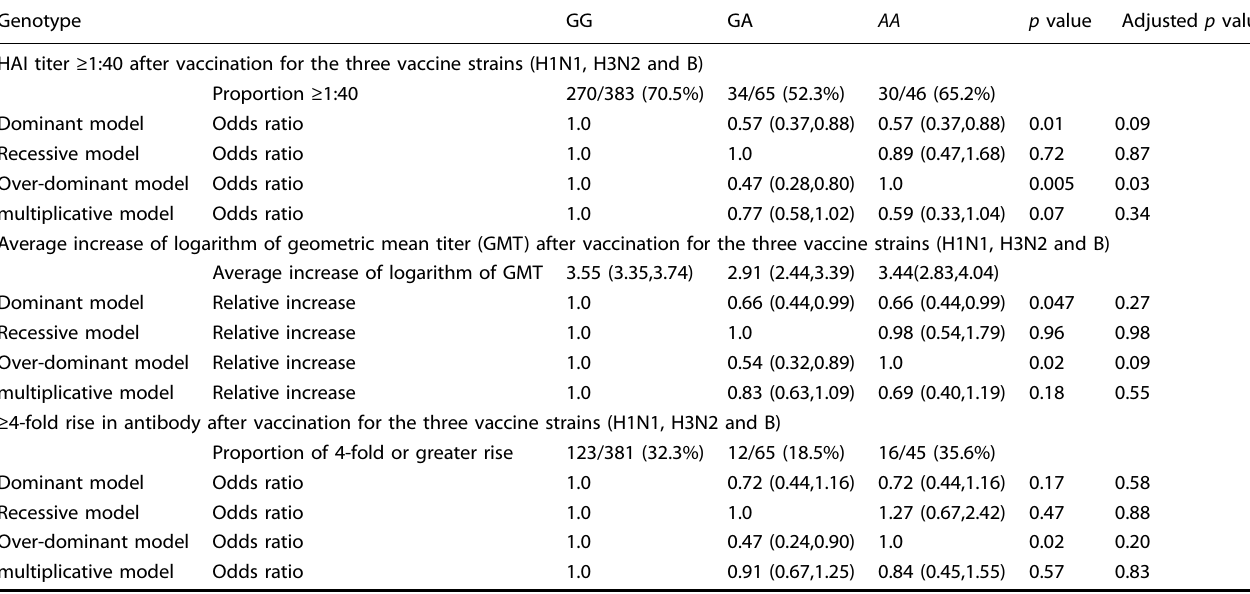
Table 2. Relationship between host SNPs in TLR8 (rs3764880) and vaccine response. Genotype GG GA AA p value Adjusted p